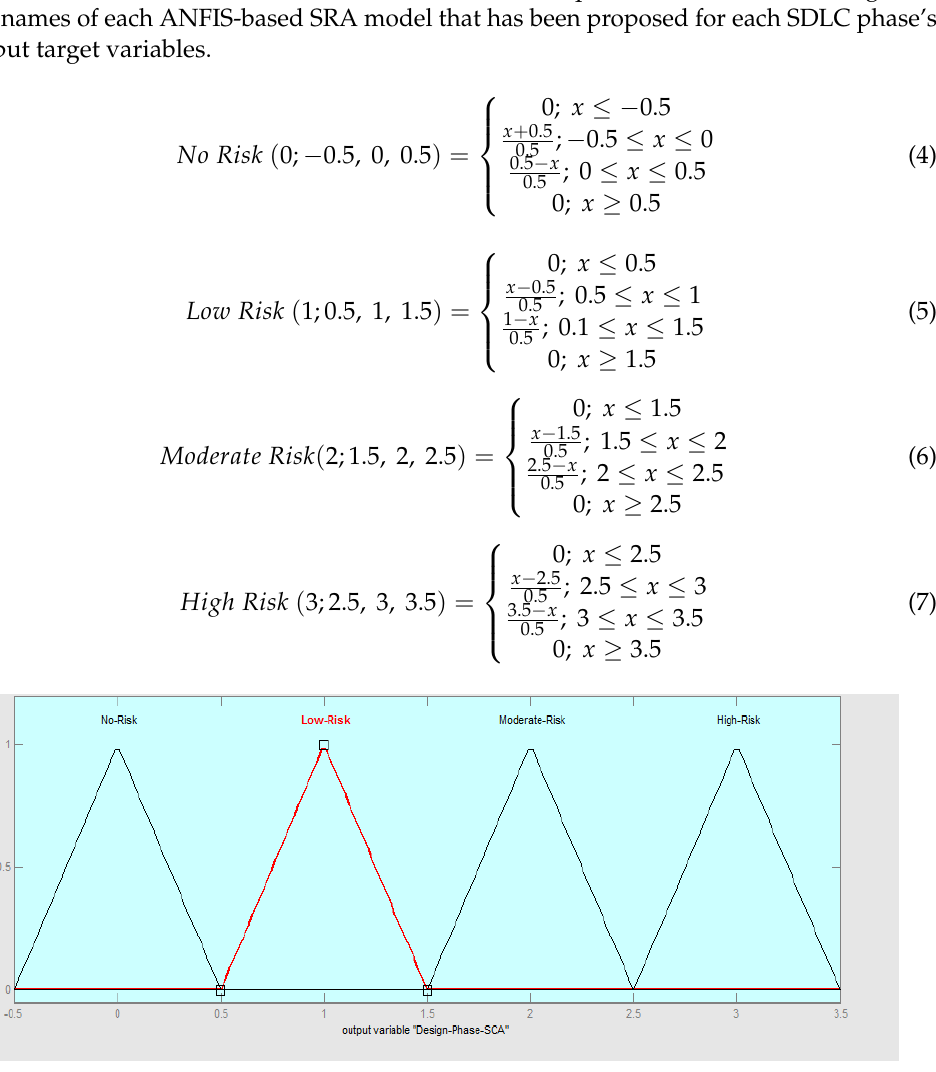
Figure 2. The triangular membership function for SRA